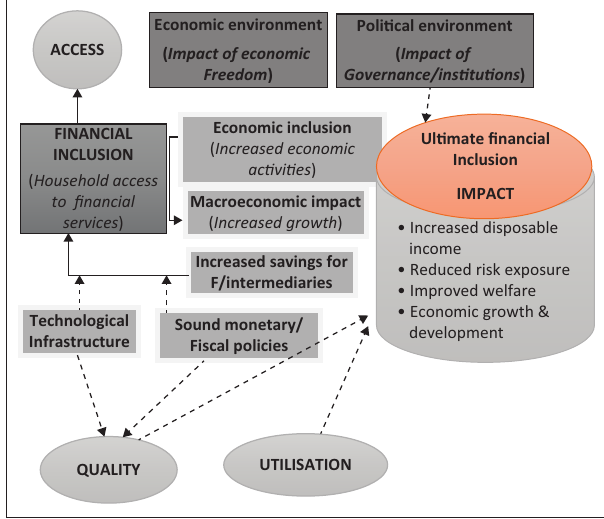
FIGURE 1: Trajectory and dimensions of economic and financial inclusions involving institutional quality (economic freedom) and